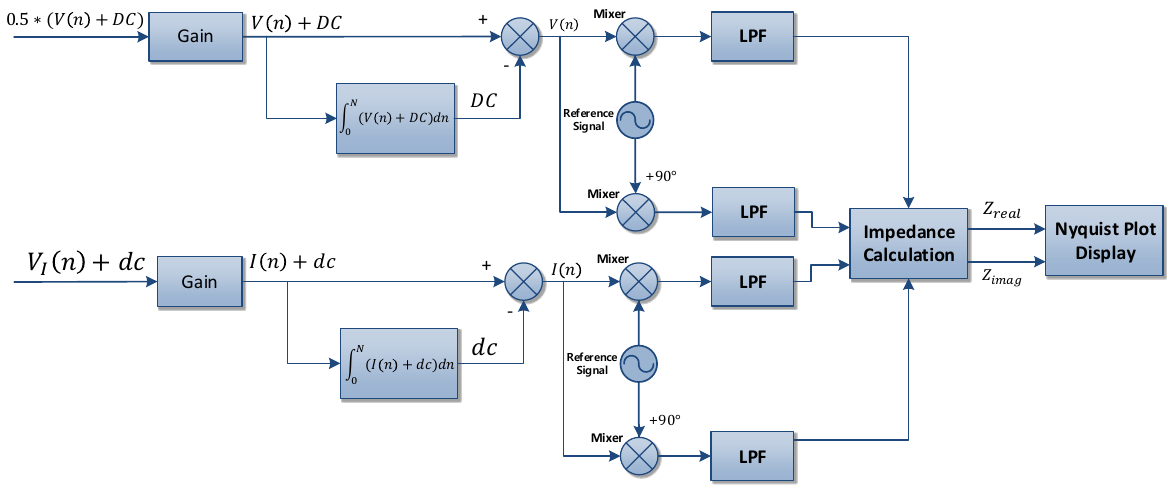
Figure 11. Block diagram for workflow of developed software.